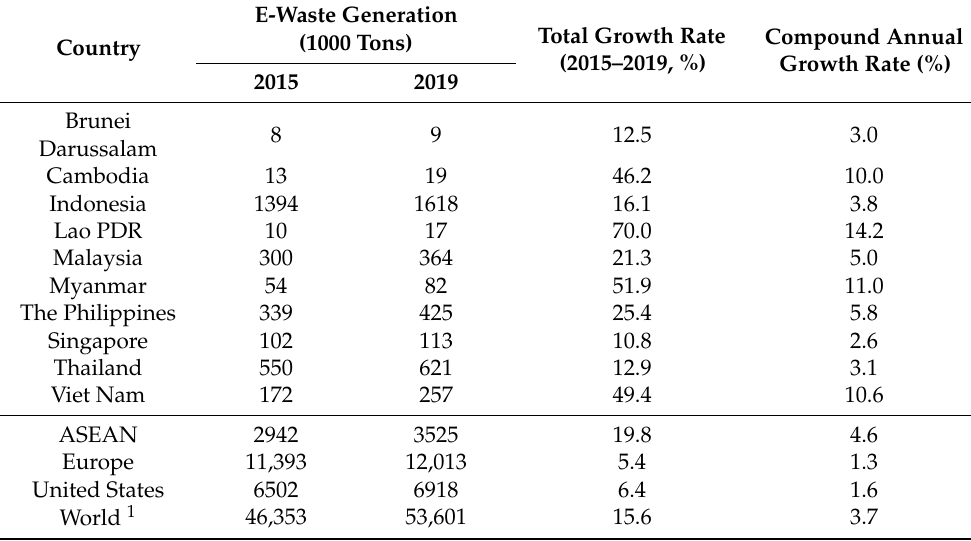
Table 1. Changes in the E-waste